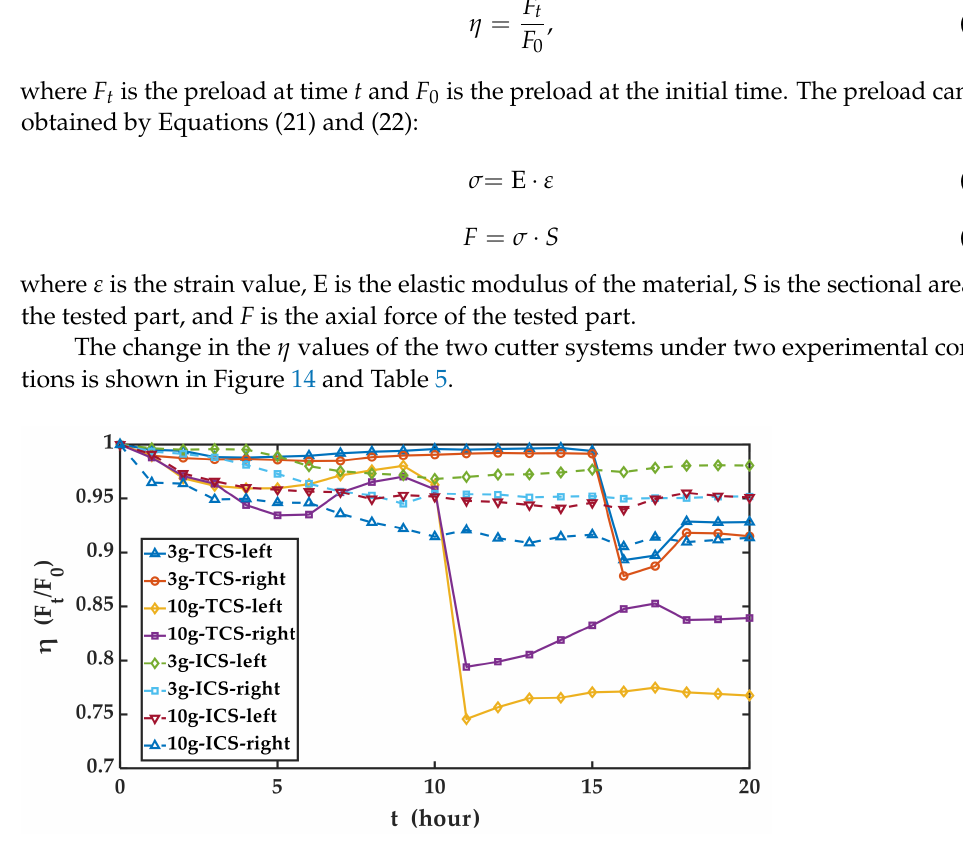
Figure 14. The value change of η for two types of cutter systems under two kinds of working